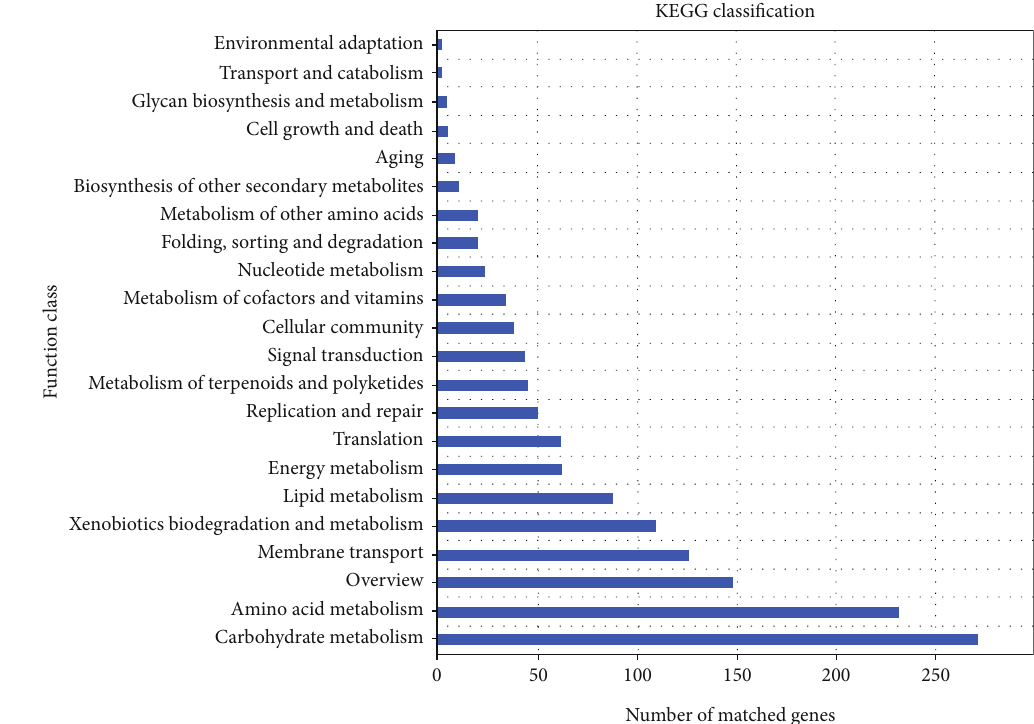
Figure 5: Kyoto Encyclopedia of Genes and Genomes (KEGG) annotation of genome. X -axis, number of matched genes; Y -axis (right), function